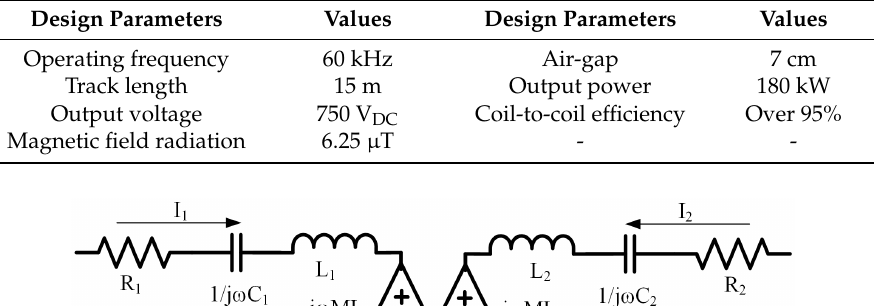
Table 1. Wireless power transfer (WPT) system design requirements.